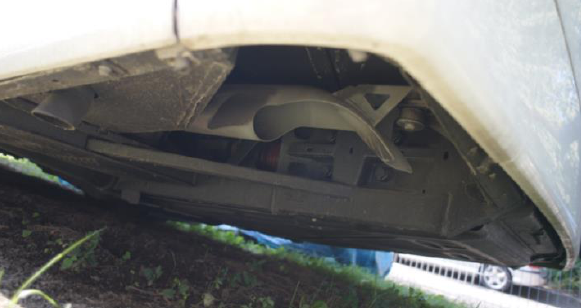
Fig. 1. Test vehicles – Mercedes Actros 1842 truck (top) and Mercedes Tourismo coach (bottom) The Capelec Cap 3201 analyzer used for the measure- ments consisted of two modules: a five-gas exhaust gas